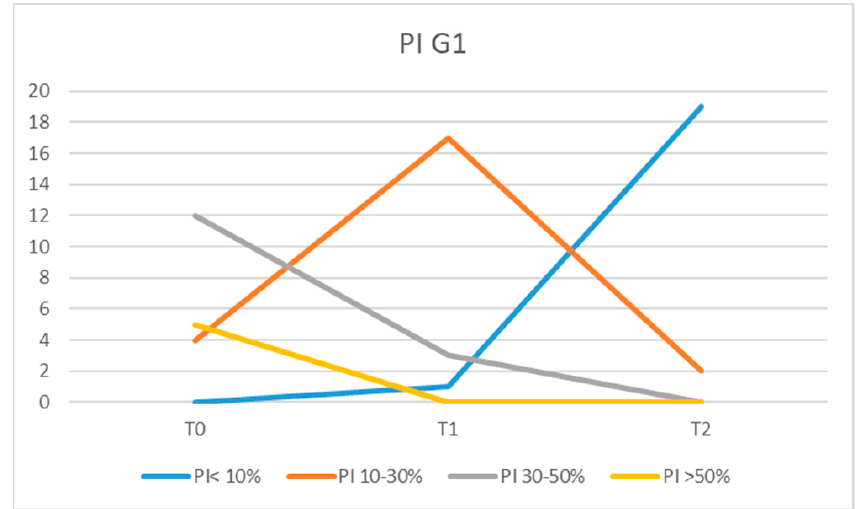
Figure 2 . Values of PI in G1 at T0, T1, and T2 . Figure 2. Values of PI in G1 at T0, T1, and T2. The values recorded for PI in patients from group G2 at T2 moment, were low in most patients compared with the T0 moment. The values recorded at T2 were PI > 50% for three patients, PI = 30–50% for four, PI = 10–30% in eight of the patients, and PI < 10% in six of them (Figure 3). However, three patients had PI values similar to those recorded at moment T0, and two patients showed higher PI